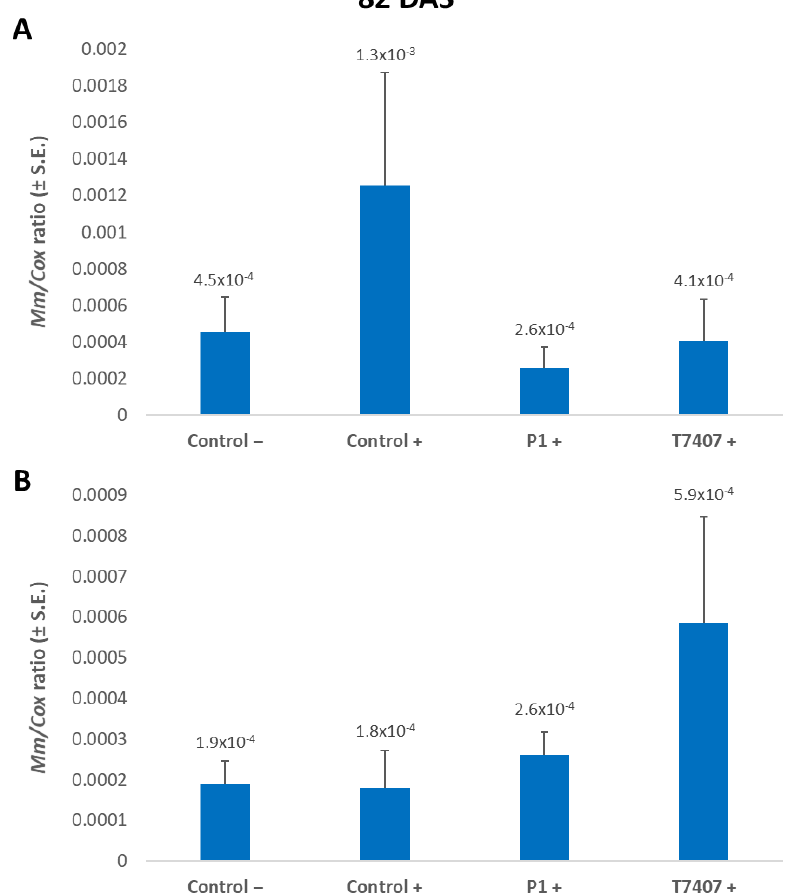
Figure 7. A qPCR estimate of M. maydis DNA at the end of the 2020 field experiment. ( A ) Stabbing- free treatments. ( B ) Stabbing inoculation treatments. The relative amount of DNA ( Mm ) of M. maydis normalized to the DNA of cytochrome C oxidase ( Cox ) was assessed 82 days after sowing (33 DAF) in the plants’ first aboveground internode. The experiment’s treatments and controls are depicted in Figure 3. Error lines represent a standard error of an average of 10 repetitions (plants). No statistical difference was recognized using the one-way ANOVA